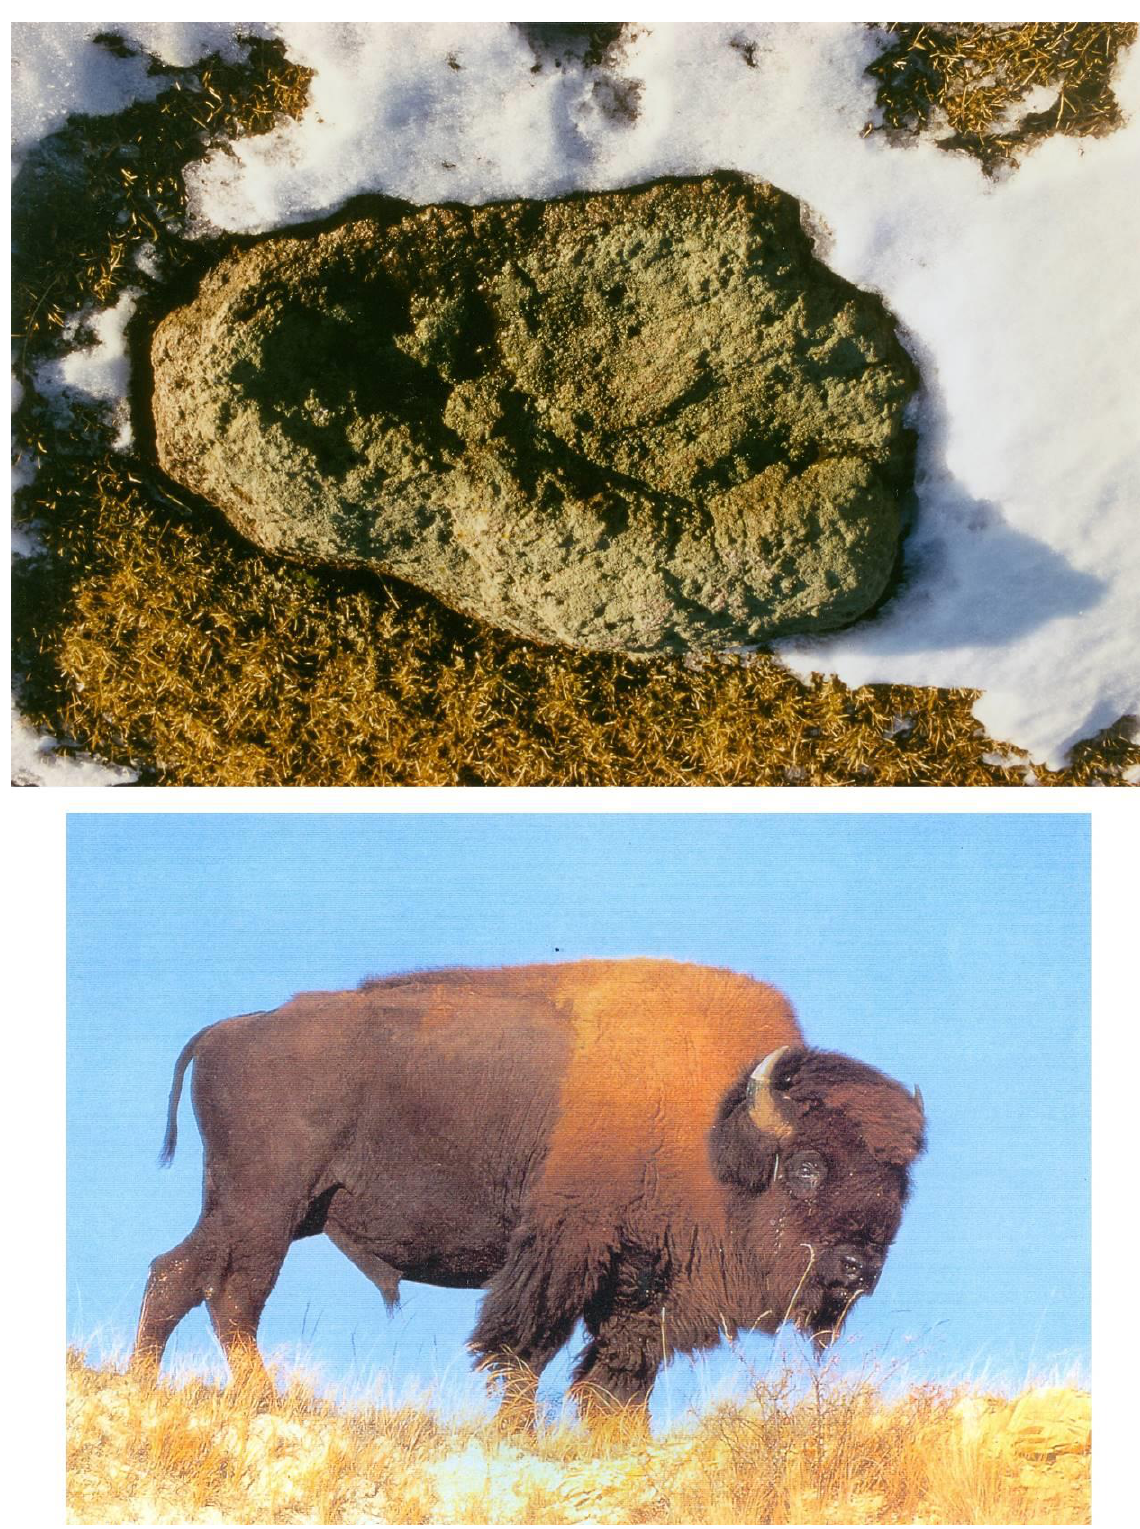
Figure 23. Photo (top) of the highly weathered, Star-being bison-shaped headstone. In the grazing light of the late Fall and early Winter the eye detail and what may have been a horn are apparent. Note the cleaved flat, straight and perpendicular back (west) end and dip like that on buffalo in viewed in full profile (bottom photo). When fresh, the red rhyolite porphyry headstone was a deep red